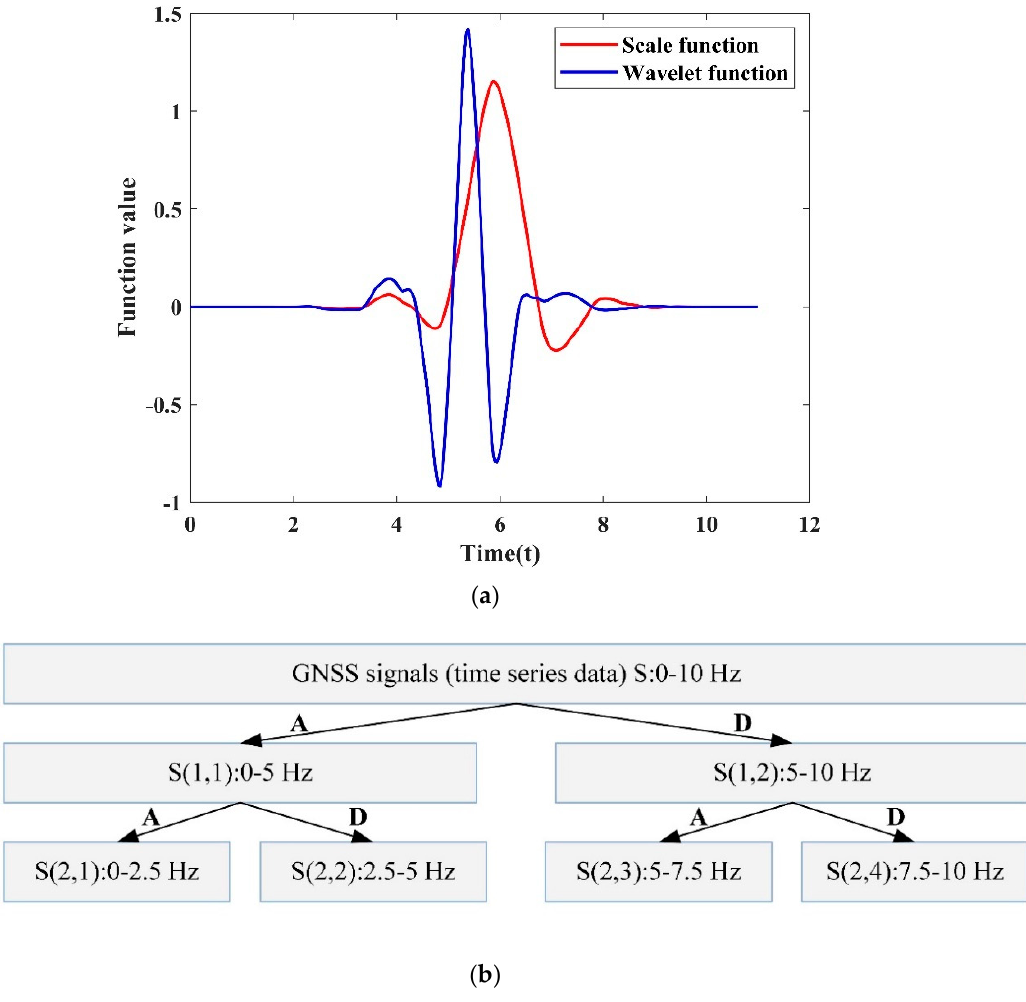
Figure 1. ( a ) Scale and wavelet functions of Sym6, ( b ) two decomposition level of 10 Hz Global Navigation Satellite System (GNSS)